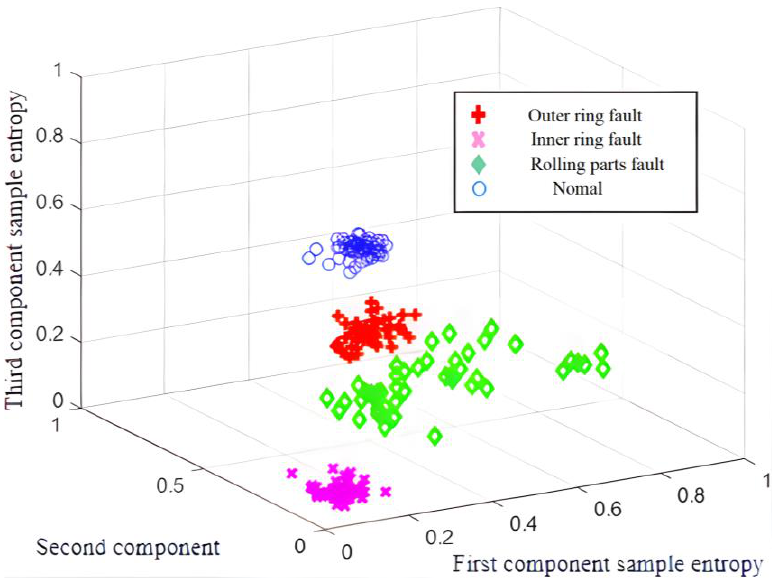
Figure 13. IPSO-VMD component sample entropy map of different state signals.